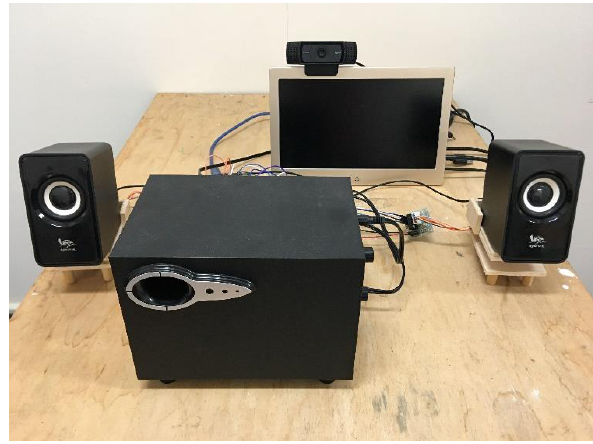
Figure 7. Prototype of autonomous 2.1 audio system.